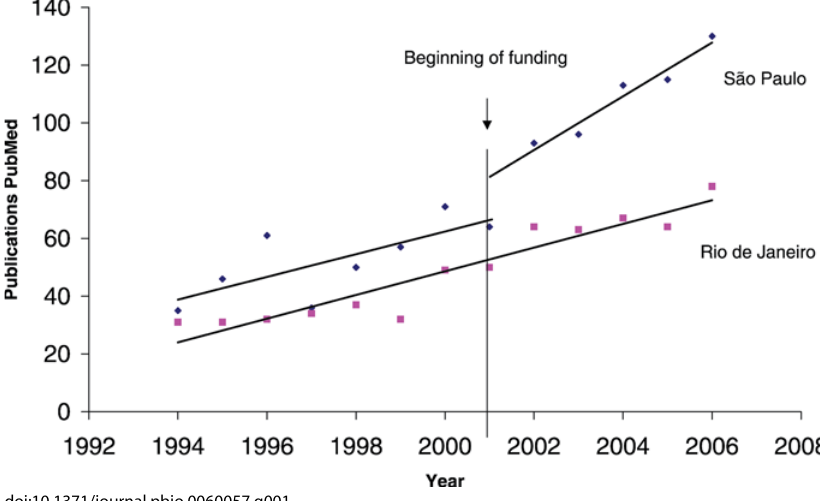
Figure 1. The Number of Virology Publications, Documented on PubMed, from 1992–2006 for the States of São Paulo and Rio de Janeiro, Brazil A major increase in publication numbers was observed in São Paulo following the onset of VGDN funding in